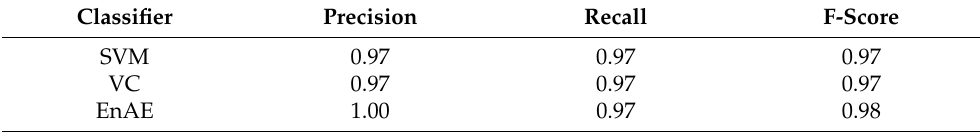
Table 6. SVM, VC and EnAE quality assessment by Table 5. SVM, VC and EnAE quality assessment by traditional criteria.